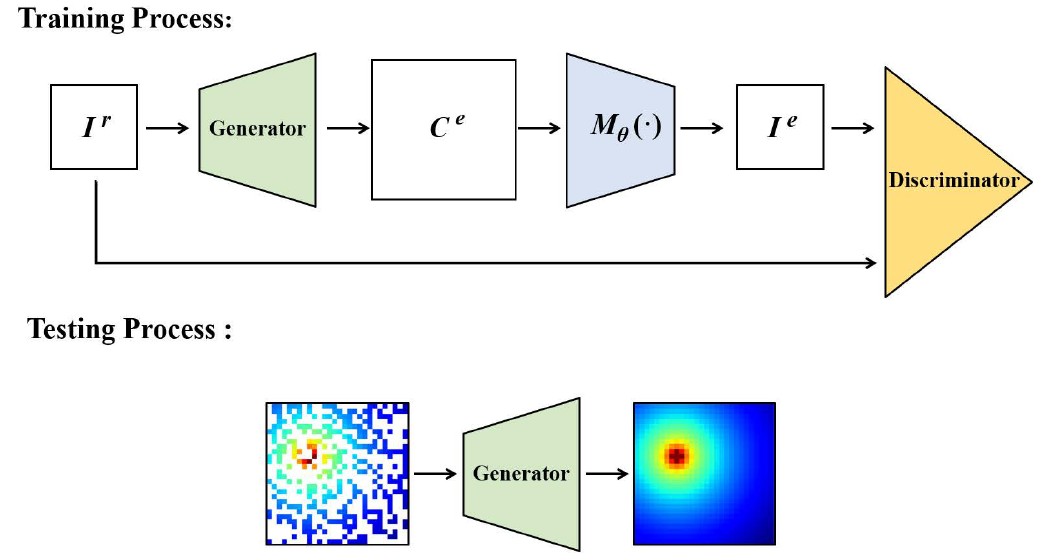
Figure 4. The pixel regression